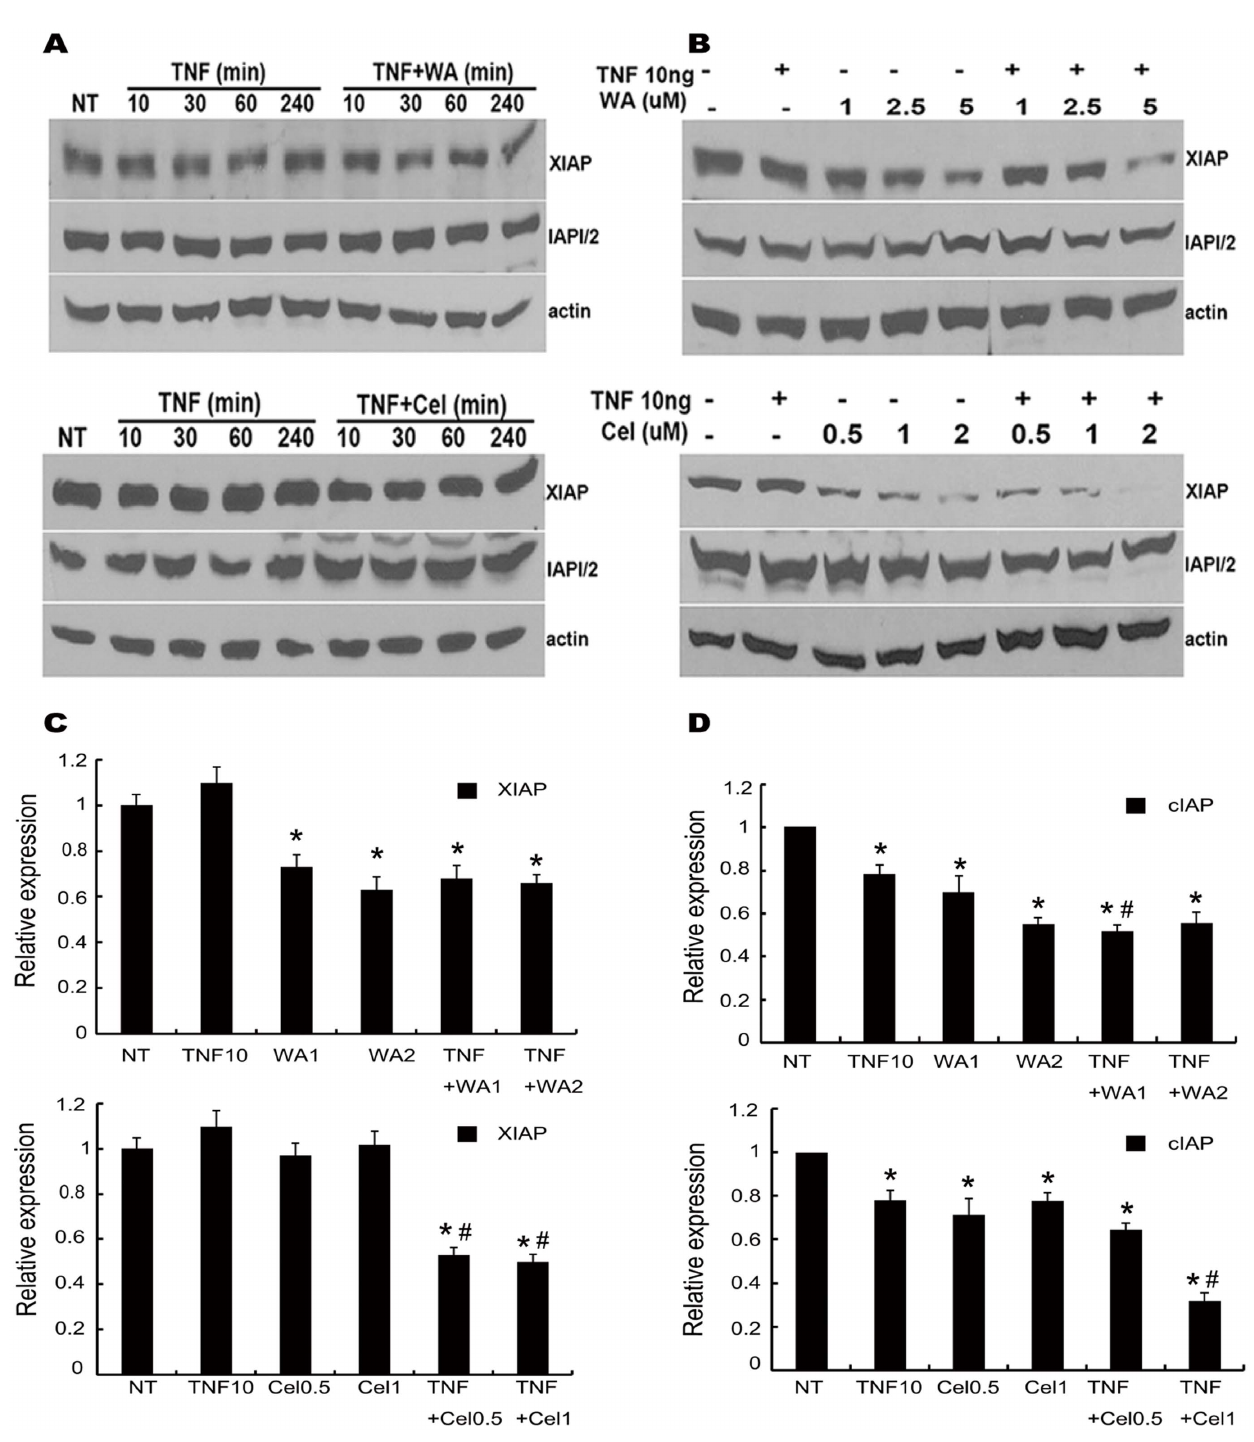
Figure 6. Kinetic and dose effects of TNF and WA/Cel combination on XIAP and IAP1/2 in cells. (A) Kinetic effects of TNF- a plus WA/Cel on XIAP and IAP1/2. Cells were treated with WA (2.5 m M)/Cel (1 m M) with or without TNF- a (10 ng/ml) for the indicated times, followed by Western blotting for XIAP and IAP1/2. (B) Dose effect of TNF- a plus WA/Cel on XIAP and IAP1/2. Cells were treated with the indicated doses of WA/Cel with or without TNF- a (10 ng/ml) for 24 hours, followed by measurement of XIAP, IAP1/2 by Western blotting. (C) Effect of TNF- a plus WA (upper)/Cel (lower) on XIAP mRNA. Cells were treated with WA (1, 2 m M)/Cel (0.5, 1 m M) with or without TNF- a (10 ng/ml) for 12 hours, followed by measurement of XIAP mRNA by RT-qPCR. (D) Effect